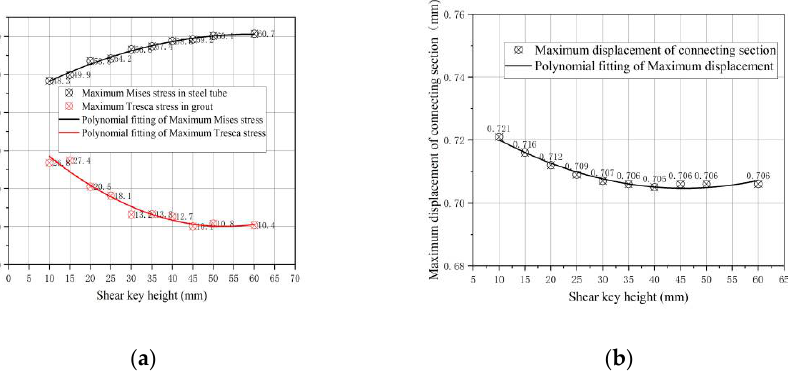
Figure 10. Variation trend of maximum stress/displacement of joints with shear key in different heights. ( a ) Maximum stress. ( b ) Maximum vertical displacement.